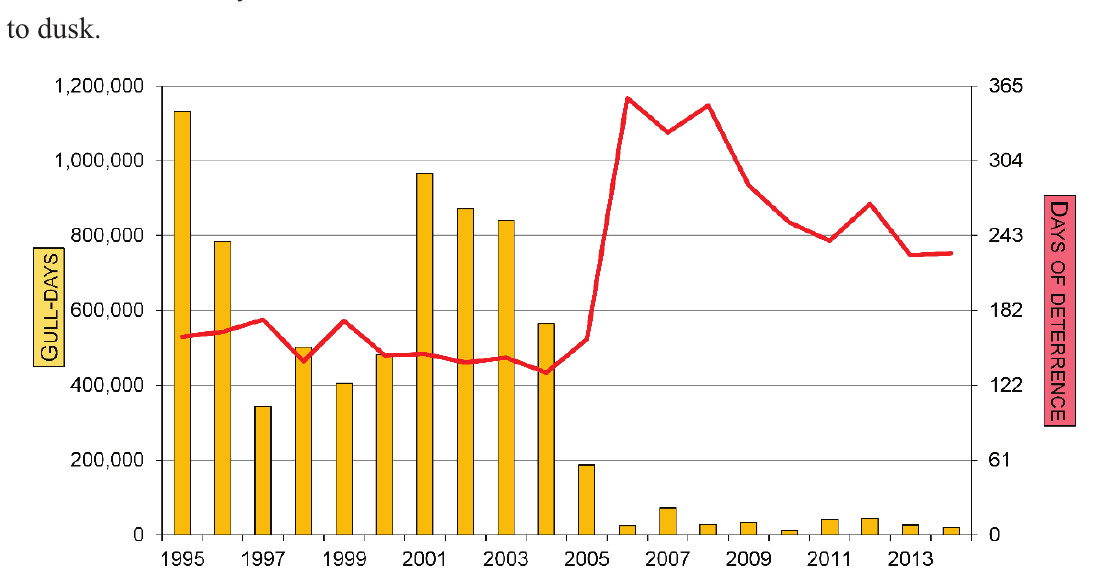
Figure 1. Use of the Terrebonne landfill by gulls and the number of days with deterrence activities, 1995–2014. The number of gull-days represents the sum of the maximum number of gulls observed during any one observation period each day between 1 April and 13 December each